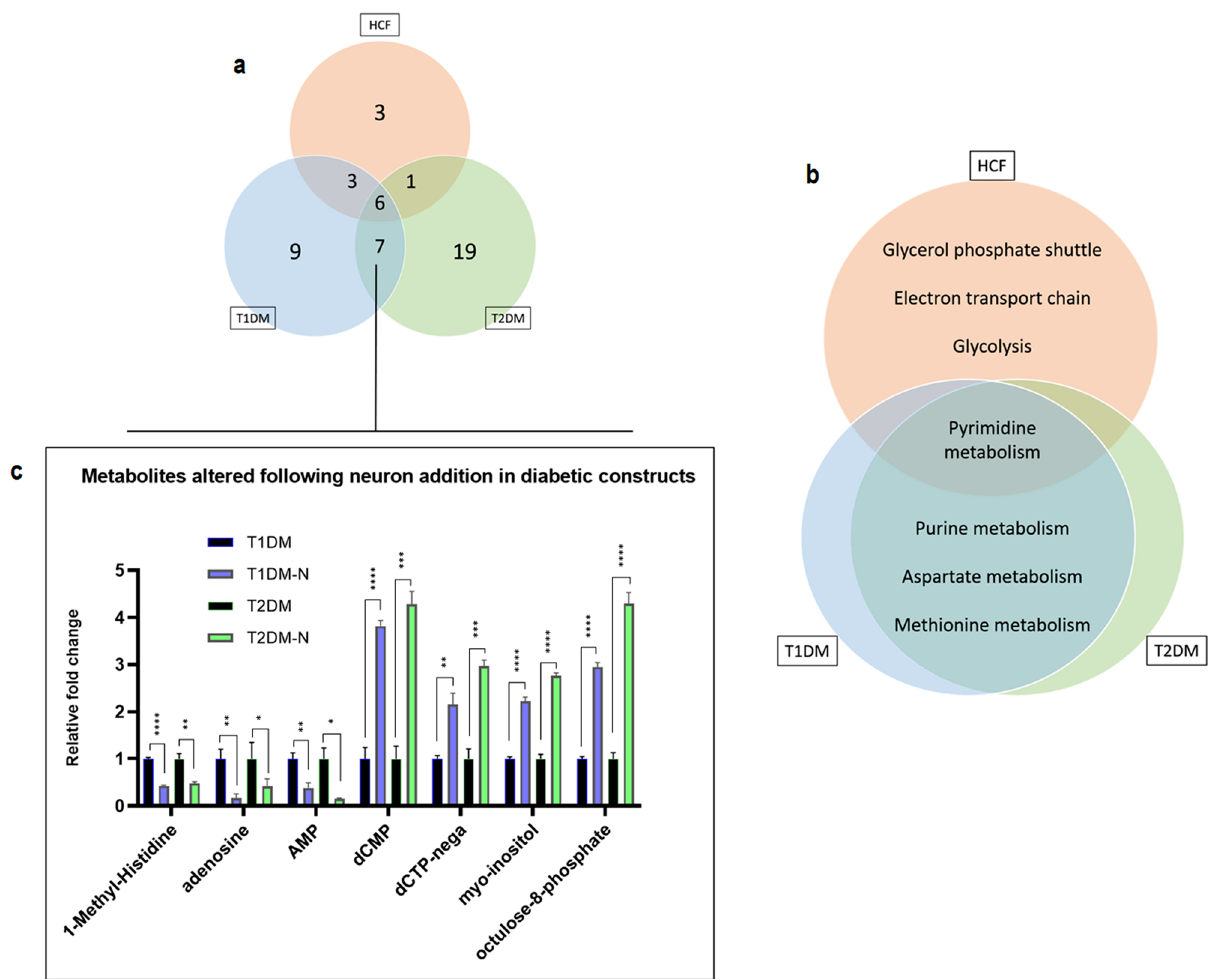
Figure 2. The effect of neurons on metabolism. Representative Venn diagrams of ( a ) the number of shared metabolites that were altered following neuron addition, and ( b ) the top four most significantly altered pathways for each cell type following neuron addition. ( c ) Graph exhibiting all metabolites significantly altered in both the diabetic constructs and not the healthy, following neuron addition. n = 3–4, student’s t test, p: *≤ 0.05; **≤ 0.01; ***≤ 0.001; ****≤